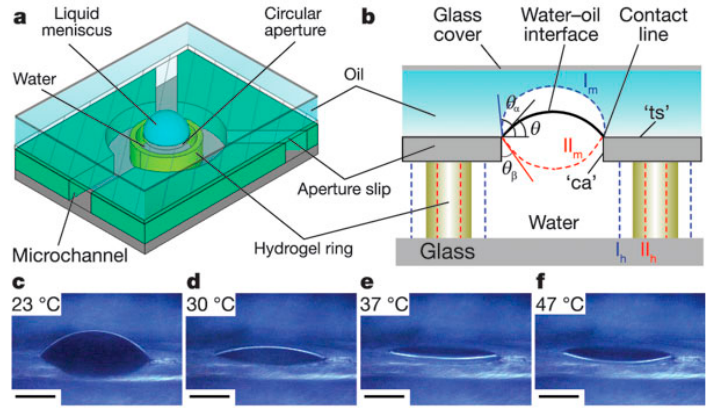
Figure 3. ( a ) Experimental setup; ( b ) liquid meniscus in a circular aperture via the pinned contact line formed by the top hydrophobic surface, represented by ts and hydrophilic bottom substrate and sidewalls. The contact angles ca are modulated by an entrapped stimuli-responsive hydrogel. Dashed blue lines represent a divergent lens while red dashed lines correspond to the convergent lens profile. ( c – f ) Morphology of the water–oil interface at different temperatures. Reprinted by permission from Macmillan Publishers Ltd.: Nature , Dong et al. [35], copyright 2006.